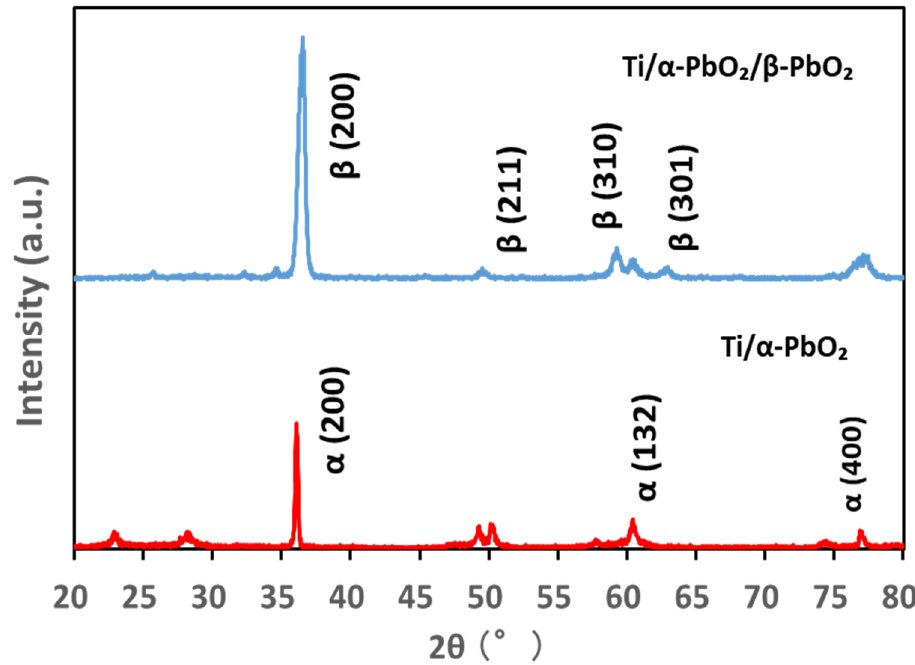
Figure 1. XRD spectra of Ti/α-PbO 2 and Ti/α-PbO 2 /β-PbO 2